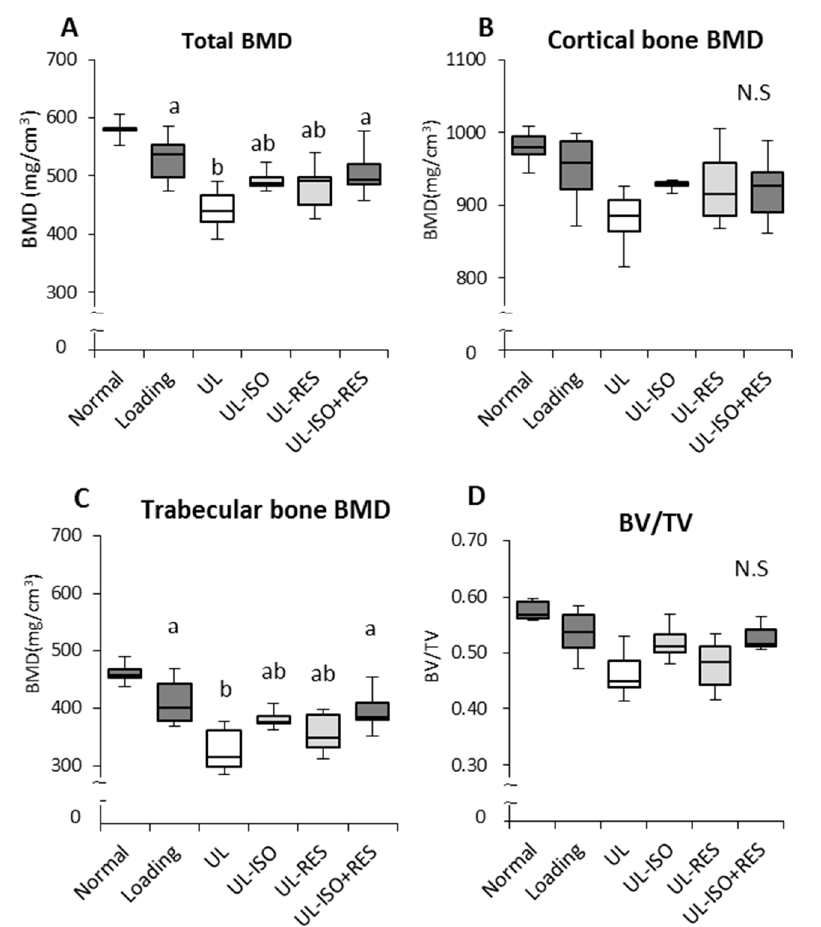
Figure 2. Bone mineral density (BMD) and bone volume per tissue volume (BV / TV) in femur in hindlimb-unloading mice. Normal, normally housed group; Loading, loading group; UL, hindlimb-unloading mice fed a control diet; UL-ISO, hindlimb-unloading mice fed a 0.16% soy-isoflavones conjugates diet; UL-RES, hindlimb-unloading mice fed a 0.15% RES diet; UL-ISO + RES; hindlimb-unloading mice fed a 0.16% soy-isoflavones conjugates and resveratrol diet. BMD of ( A ) the total, ( B ) Cortical and ( C ) trabecular bone on distal femur, and ( D ) bone volume per tissue volume (BV / TV) were analysed by micro-computed tomography scanning. Values are the mean ± SEM ( n = 6–8). The data were analysed using one-way analysis of variance (ANOVA). The Normal group was not included in the statistical analyses. Di ff erences among the groups were assessed by Tukey’s post hoc test. If variances were not equivalent, the data analysed Kruskal–Wallis ANOVA, and followed by a Steel-Dwass test. Di ff erences were considered significant when P < 0.05. a, b Mean values with unlike letters were significantly different.